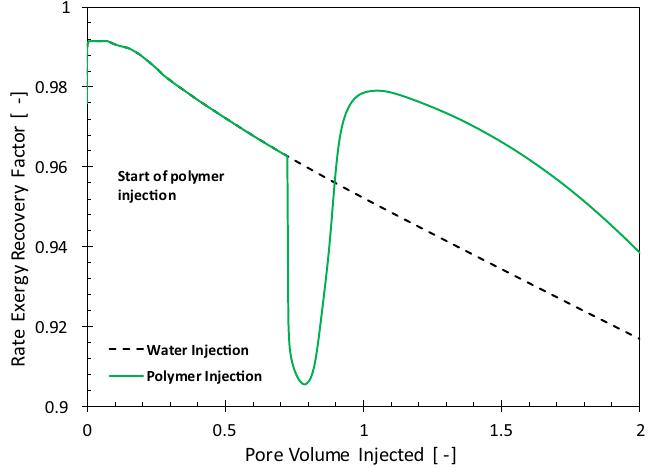
Figure 4. History of the rate exergy recovery factor (Ex RF ) for polymer (solid line) and water-injection (dashed line) cases.